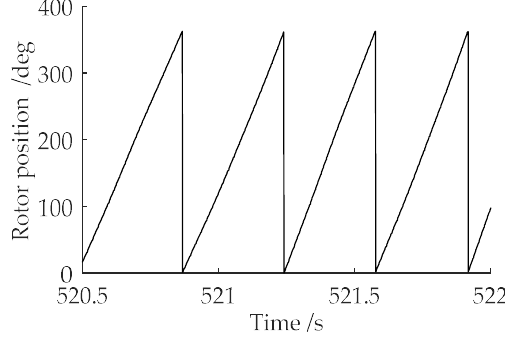
Figure 13. Rotor position of RW-EESM